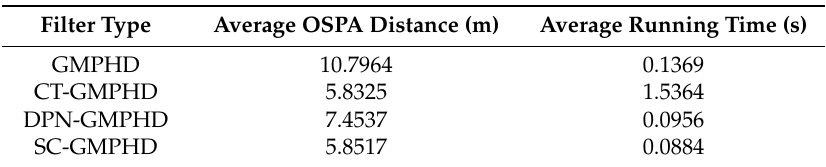
Table 6. Average OSPA distance and running time of the different filters versus the detection probability when the clutter rate is equal to 60.